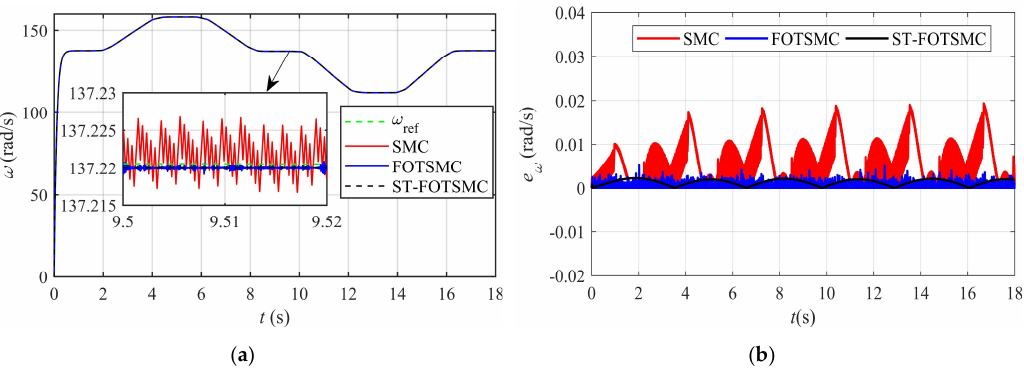
Figure 11. ( a ) Speed response under parametric uncertainties; ( b ) speed error comparison under lumped uncertainties.